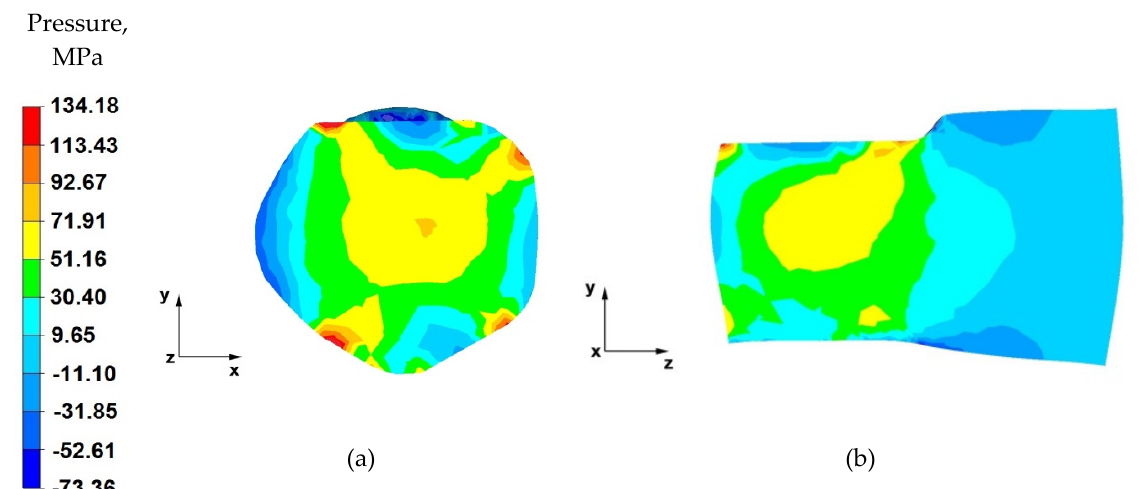
Figure 13. Distribution of the hydrostatic pressure of the AZ 91 alloy forging, deformed in the third pass with 40% reduction in trapezoid and diamond anvils after slanting by 90 ◦ : ( a ) on the cross-section, ( b ) on the longitudinal section.